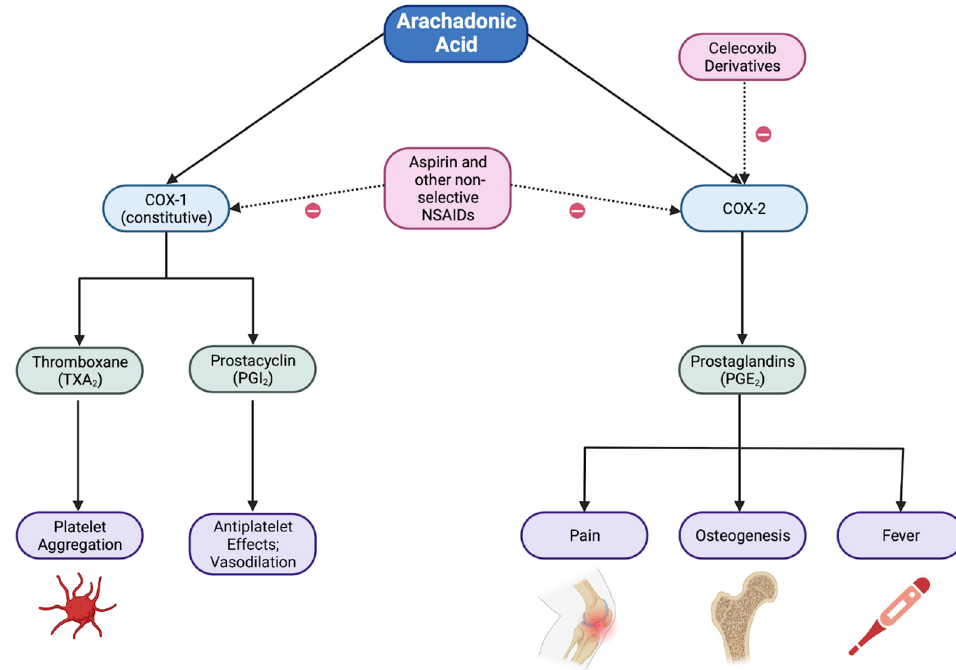
Figure 2. A summary of the cyclooxygenase (COX) pathways and their effects. Celecoxib and its derivatives selectively block the COX-2 pathway, inhibiting pain, inflammation, and fever without impacting platelet aggregation [7,8].